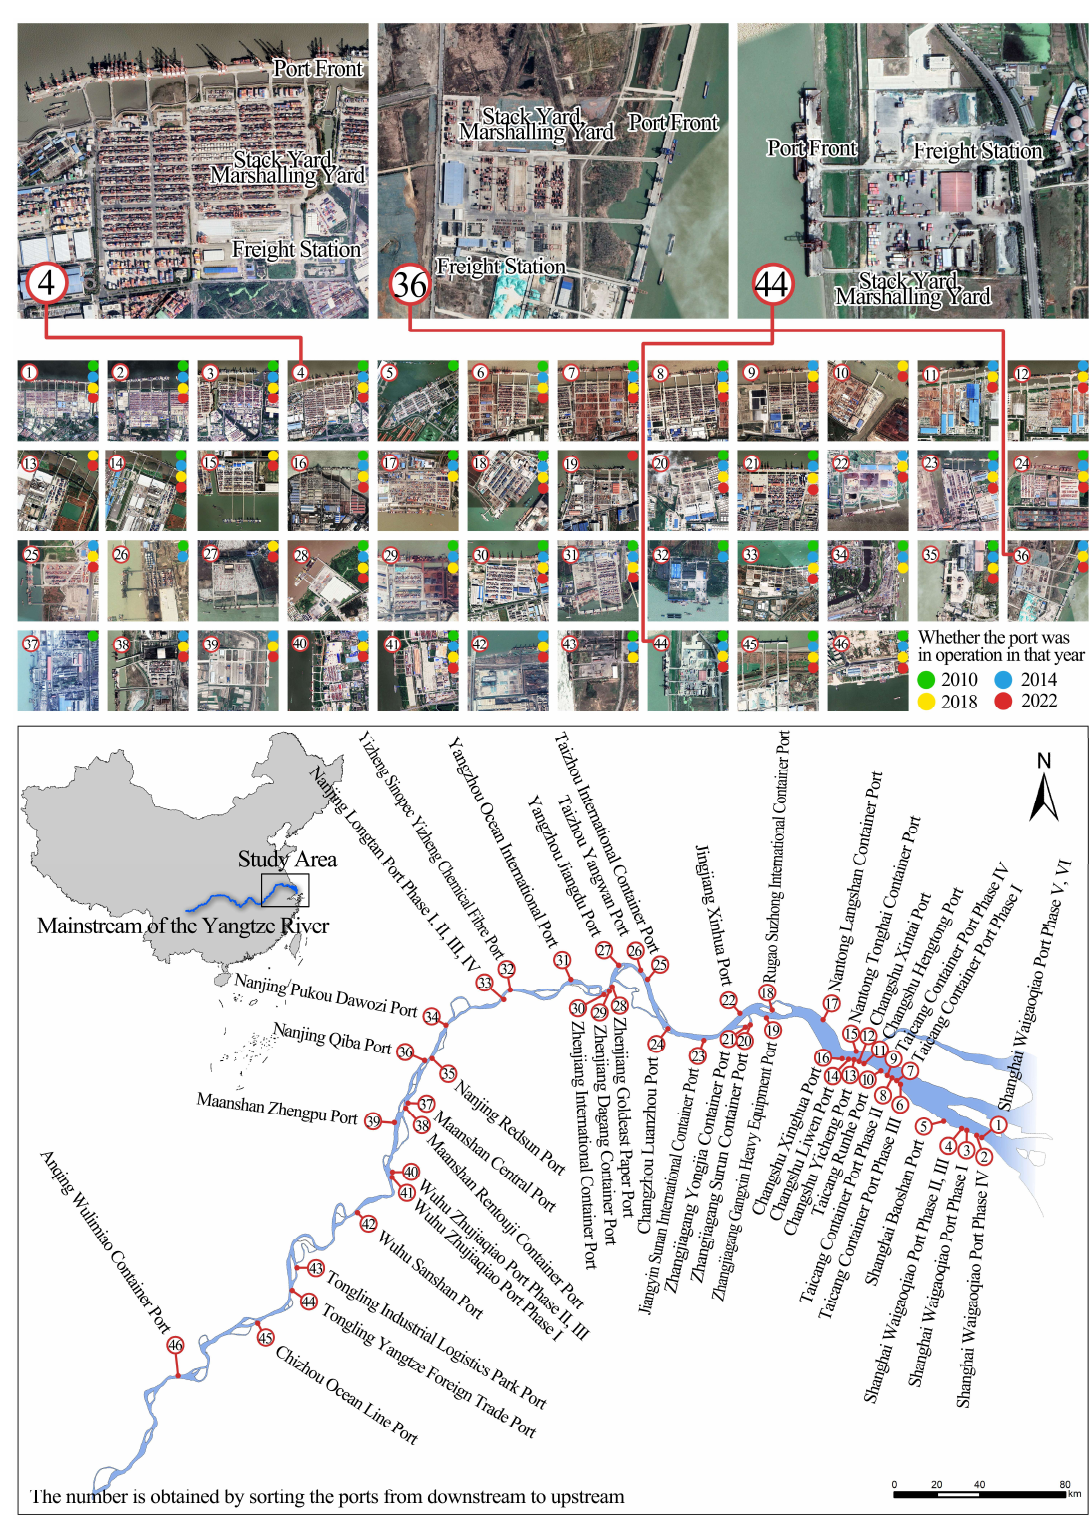
Figure 2. Identification of the container port waterfront.